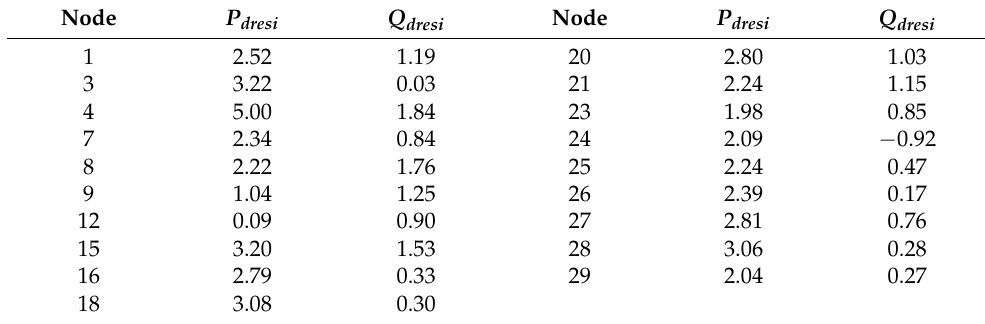
Figure 10. Pareto front.